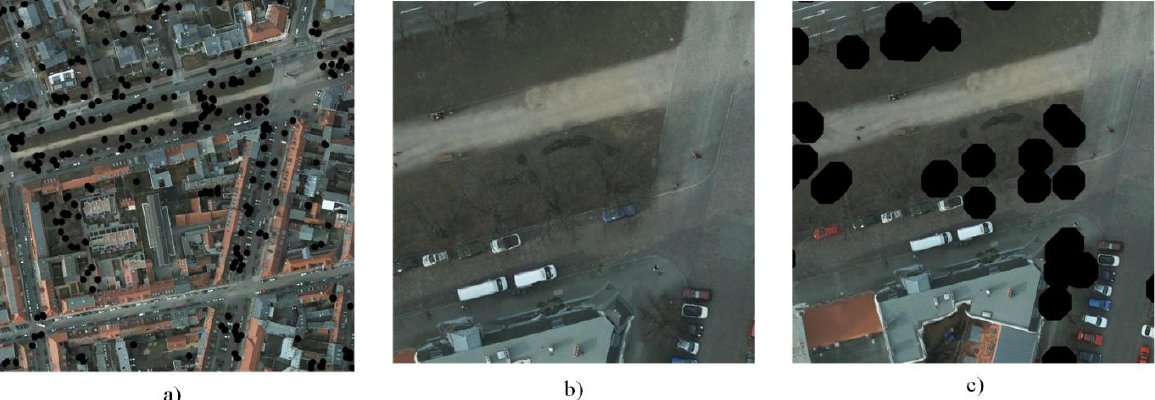
Figure 12. Tree refinement on a part of patch No. 5-11 a) Leafless tree detection b) Part of original image c) Leafless tree detection in a part of